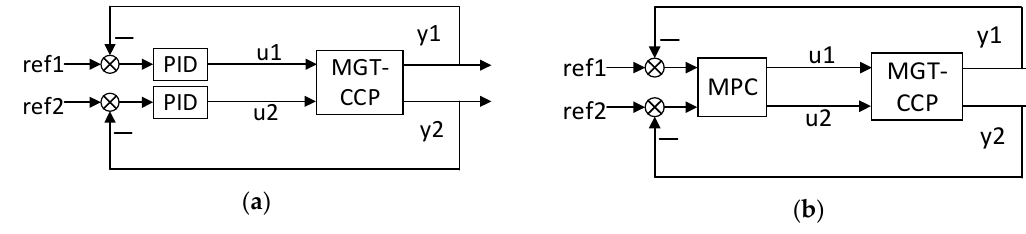
Figure 10. Control structure of comparison methods. ( a ) PID; ( b ) MPC.